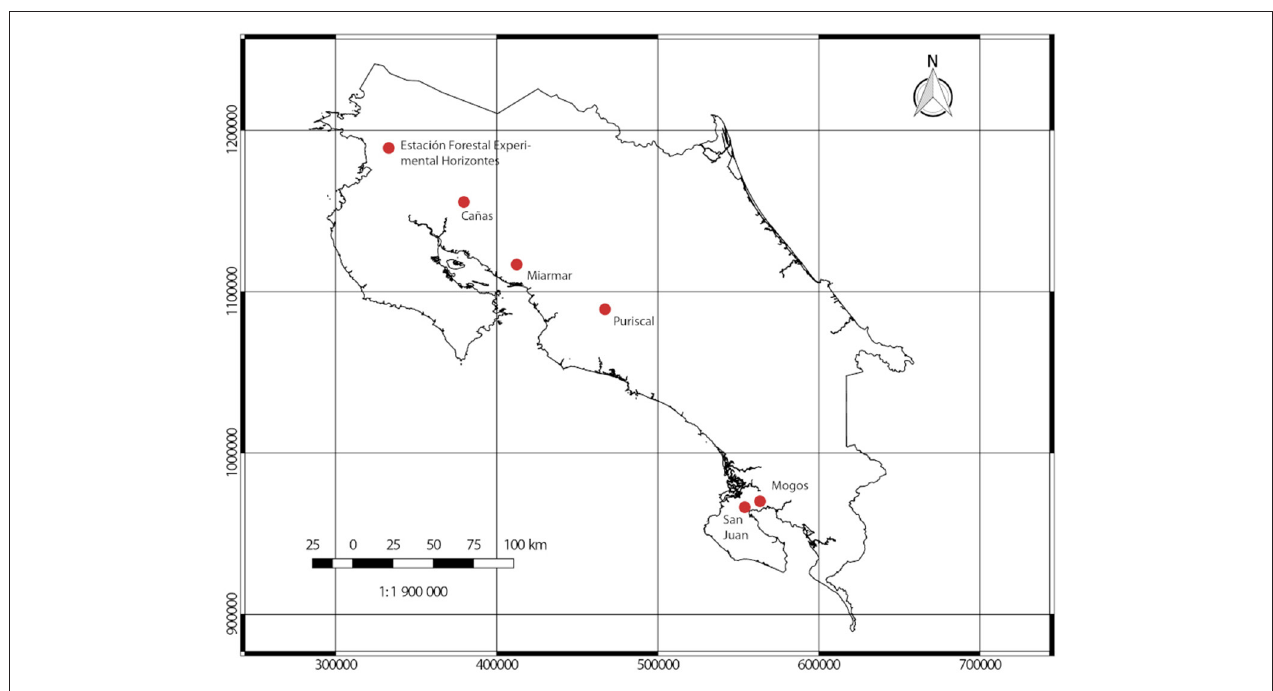
FIGURE 2 | Location of forest reserves selected for sample collections.